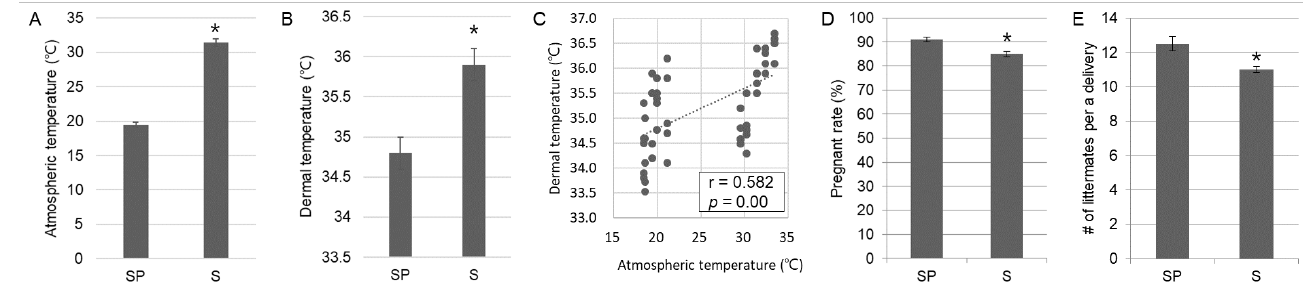
Figure 1. Heat stress factors and reproductive performance during summer of domestic sows. Atmospheric ( A ) and dermal ( B ) temperatures significantly ( p < 0.05) increased in summer and both are presented as linear regression with a high correlation value (r = 0.582) ( C ). Significant ( p < 0.05) reductions in reproductive performance such as pregnancy rate ( D ) and the number of littermates per delivery ( E ) are observed in the summer group. The values in B and C are obtained from 50 domestic sows ( n in SP = 25 and n in S = 25). The values in ( D , E ) are based on each farm’s reproductive performance records ( n = 5). Significant differences ( p < 0.05) are indicated by superscripts * at the top of the bars. Graphs are presented as mean ± SEM. Abbreviations: SP, Spring group; S, Summer group; SEM, standard error of the mean.